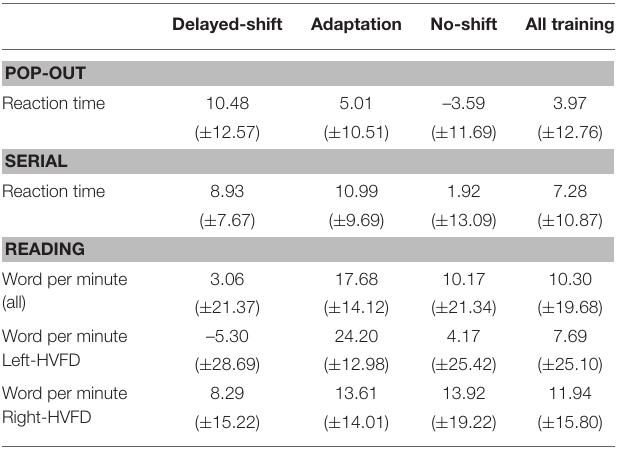
TABLE 4 | Percentage of modification ((post-phase – pre-phase)/ pre-phase)*100 ( ± SD) of functional measures for all tasks, separately for each training, and averaged over all the training (right column). Delayed-shift Adaptation No-shift All